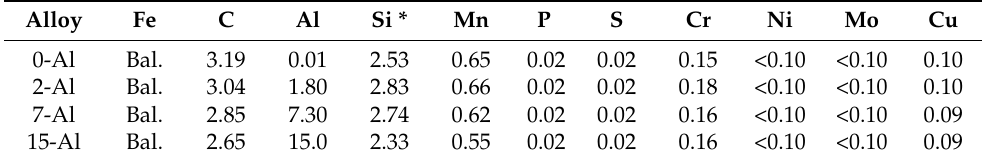
Table 2. Elemental composition of Al-alloyed cast irons in wt. % obtained by ICP.